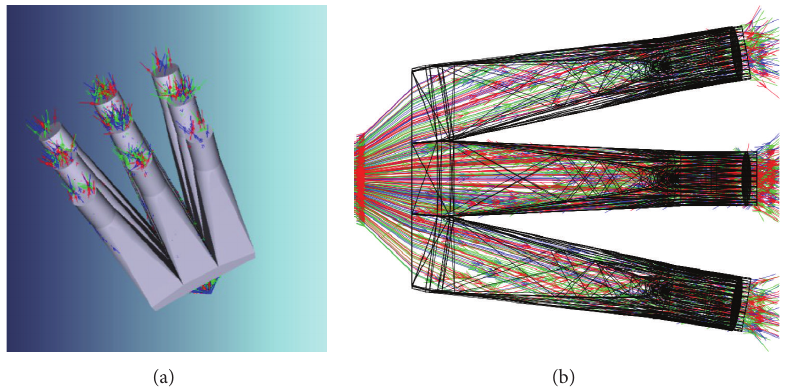
Figure 11: Layout of coupler for ray tracing: (a) shaded model and (b) 3D layout.